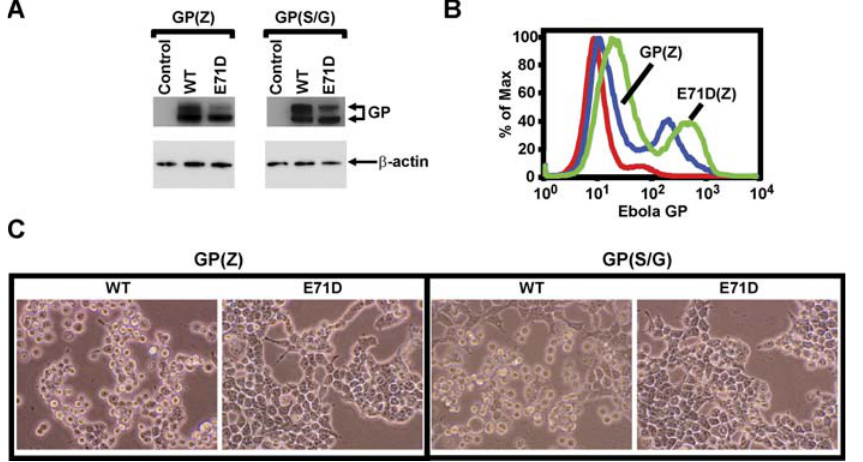
Figure 4. Elimination of GP Cytopathic Effects with Single Point Mutation (A) Expression of point mutants in HEK293 cells. Ebola GP proteins from supernatants and cell lysates were visualized by SDS-PAGE and Western blot using a polyclonal antibody against Ebola GP. (B) Reactivity of point mutants with a conformation-dependent antibody. HEK293 cells were transfected with a control plasmid (red line) or plasmids expressing wild-type (GP[Z], blue line), or mutant (E71D[Z], green line) proteins. 18 h posttransfection, cells were harvested and stained with a GP- specific antibody, and cell surface GP expression was analyzed by flow cytometry. (C) Elimination of cell rounding by amino acid substitution at position 71. HEK293 cells were transfected with a plasmid that encoded vector control, wild-type Ebola glycoprotein from Zaire (GP[Z]) or Sudan/Gulu (GP[S/G]), or their respective point mutations (E71D[Z] and E71D[S/G]). Cell monolayers were visualized under phase contrast using a Nikon 40 3 objective and photographed at 24 h posttransfection. DOI: